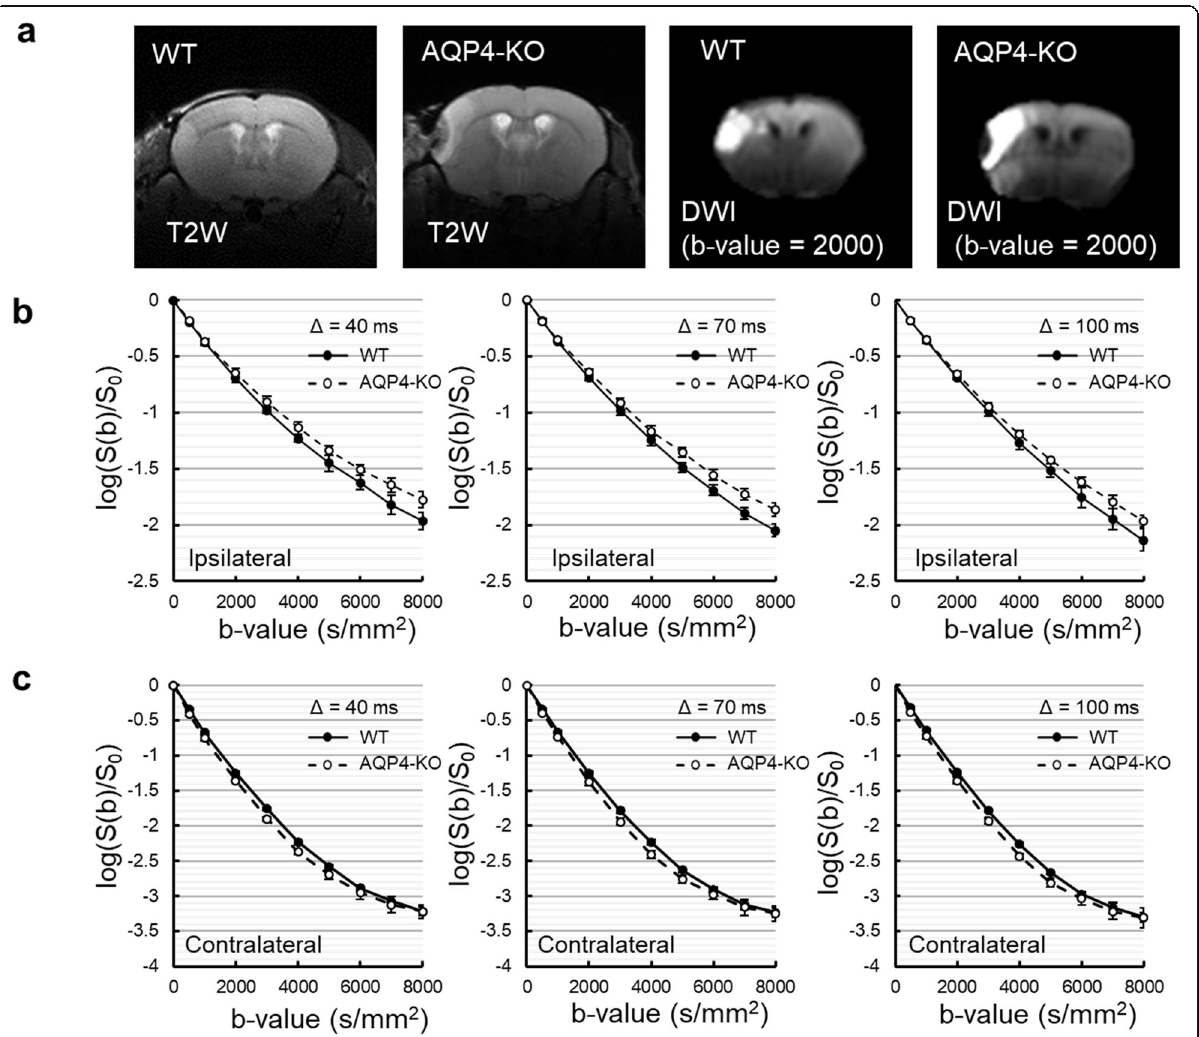
Fig. 1 Multi- b value multi-diffusion-time images of wild-type (WT) and aquaporin-4 knockout (AQP4-KO) mice. Typical T2-weighted and diffusion- weighted ( b value = 2,000 s/mm 2 ) images for WT and AQP4-KO mice ( a ). The left side of the brain had a middle cerebral artery occlusion. Normalized b -value dependent signal decay for the ipsilateral ( b ) and contralateral ( c ) sides at different diffusion-times ( Δ = 40, 70, and 100 ms). Solid lines indicate WT mice (closed circles with standard deviation bars) and broken lines indicate AQP4-KO mice (white circles with standard deviation